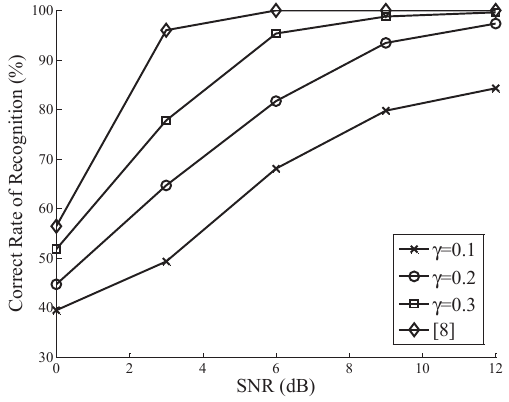
Figure 1. Performance versus signal-to-noise ratio (SNR) for Ω 1 .